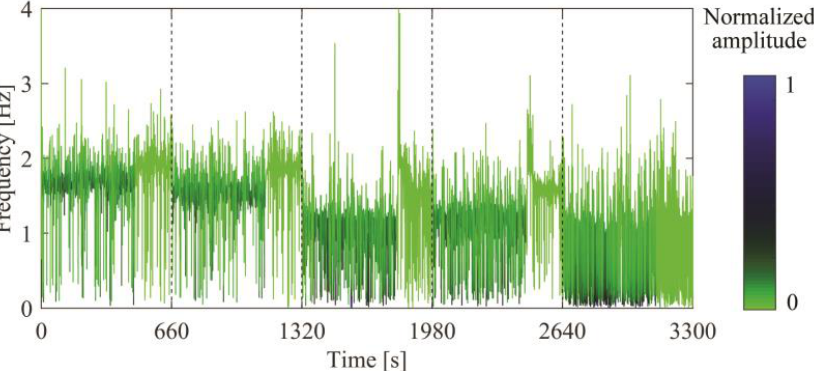
Figure 4. Weighted instantaneous frequency and overall amplitude of the first modal response. The dashed vertical lines in Figure 4 represent the occurrence of the four earthquakes parts: The response to 0.03 g of RMS white noise excitation was analyzed in the first 8 min, while low-amplitude ambient vibration was analyzed in the remaining part. This fact is also evident from the plot color, which is typically darker for larger response amplitude values (i.e., in the initial part of each damage